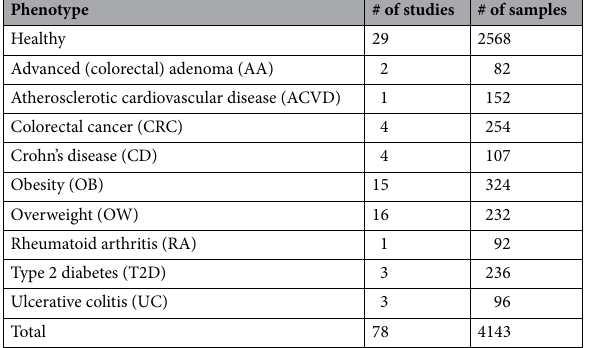
Table 1. Summary of gut microbiome datasets used in downstream gut microbiome association network